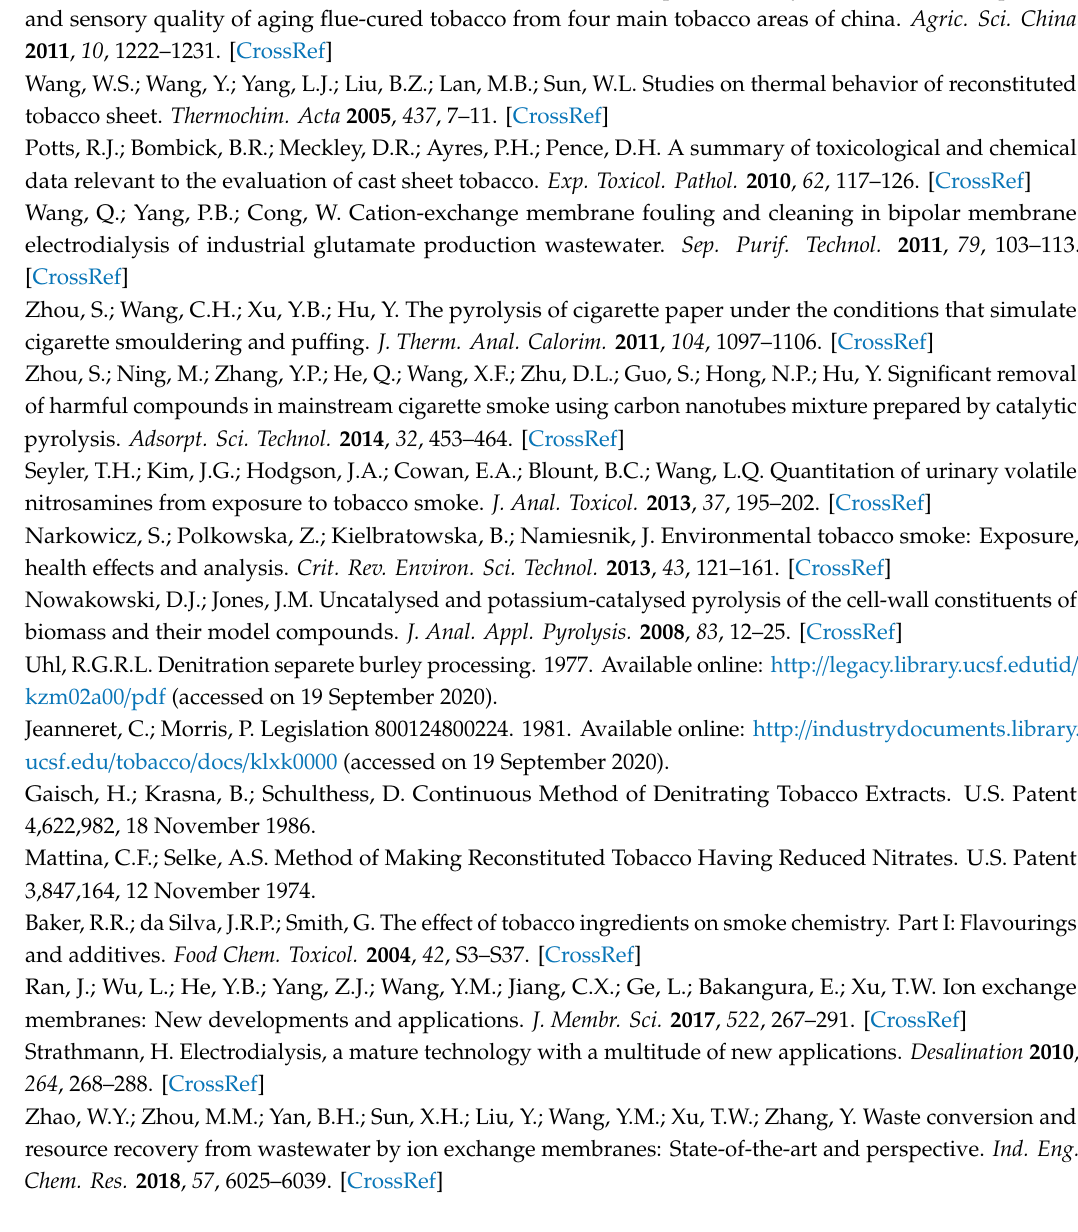
Figure S1: The SEM-EDS images of the fouled membranes ( a , e , CEM, Concentrate side; b , f , CEM, Dilute side; c , g , AEM, Concentrate side; d , h , AEM, Dilute